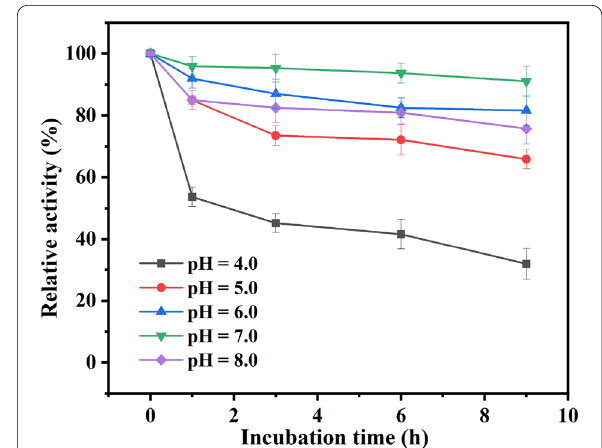
Fig. 3 pH stability of immobilized recombinant E. coli cells. Reaction conditions: 4 mL Tris–HCl buffer (200 mM, pH 7.0), 100 mM MAA, 150 mM glucose, 30 mg/mL of immobilized recombinant E. coli cells (wet weight), 40 ℃ , 200